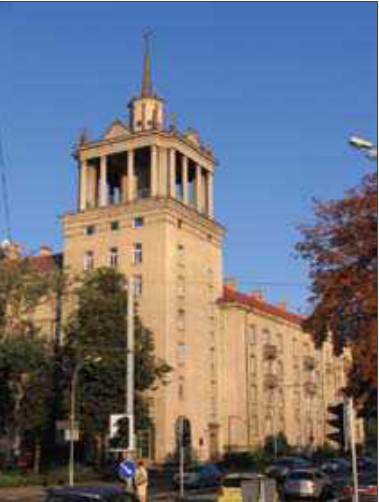
Fig. 1. “Pramogų bankas” after reconstruction (former cinema “Pergalė”) Fig. 2. housing estate